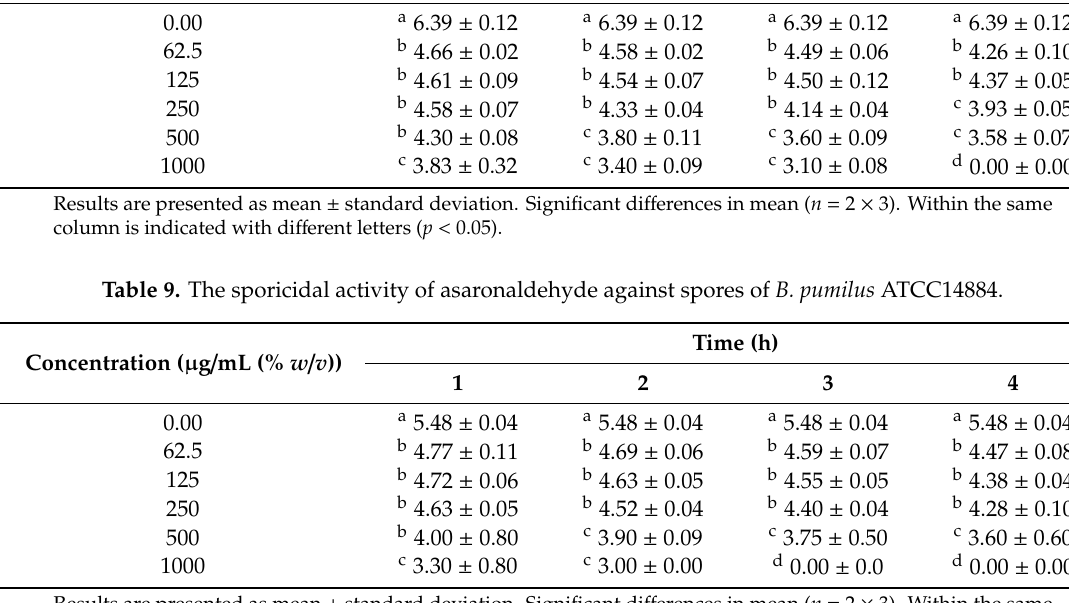
Table 8. The sporicidal activity of asaronaldehyde against spores of B. subtilis ATCC6633. Concentration ( µ g / mL (% w / v ))